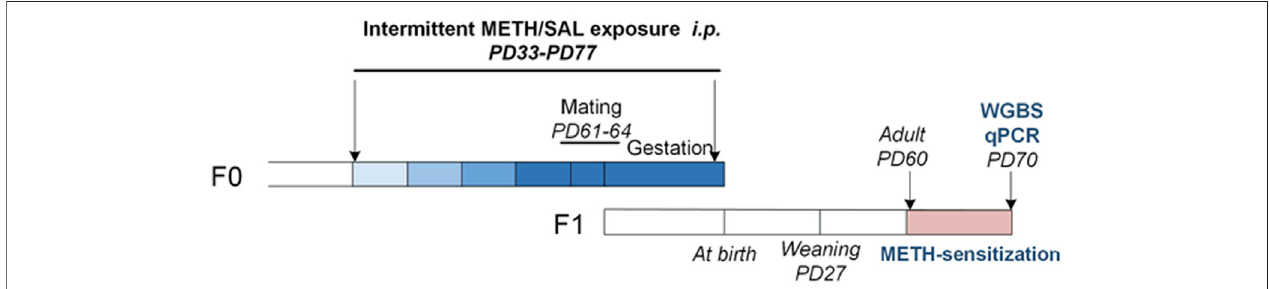
FIGURE 1 | Experimental procedure for female F0 mice METH treatment and F1 offspring mice along with approximate age ranges. The color lump from light to darkbluerepresentsescalatingdosesofMETH(0.5/1/2/4 mg kg − 1 ).Abbreviations:F0,F1(twogenerationsofagematchedmousefamilies),PD,postnatalday;WGBS, whole genome bisul fi te sequencing; qPCR, quantitative polymerase chain